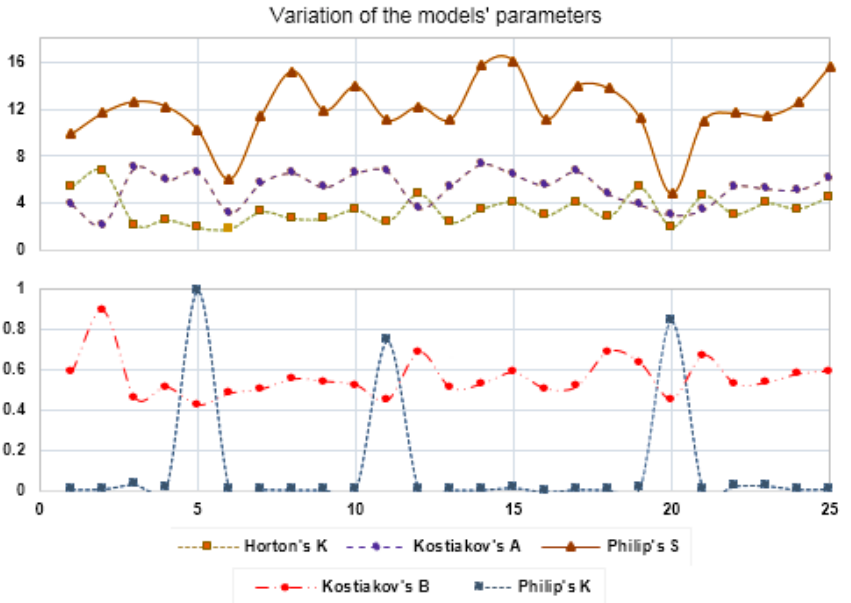
Figure 8. Variation of the three models’ parameters and infiltration rates over Medjaz Ressoul catchment. Table 4. Calculated parameters of infiltration